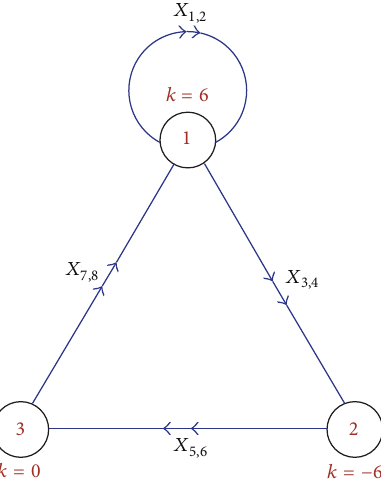
Figure 5: Quiver diagram for Fano B 3